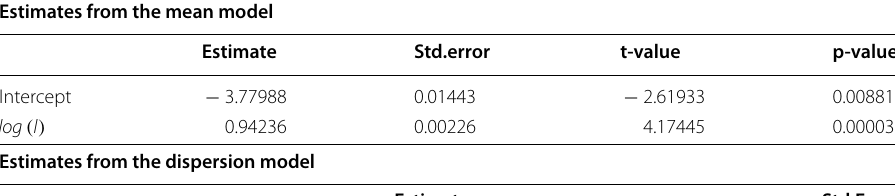
Table 1 Results for fabric study Estimates from the mean model Estimate